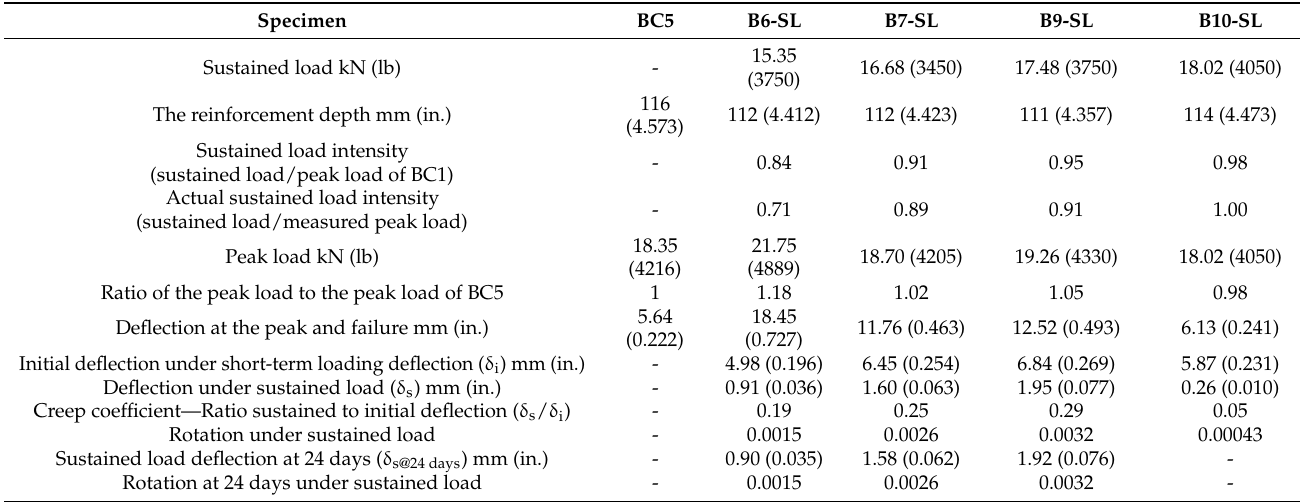
Table 4. Beam series II test matrix and results.